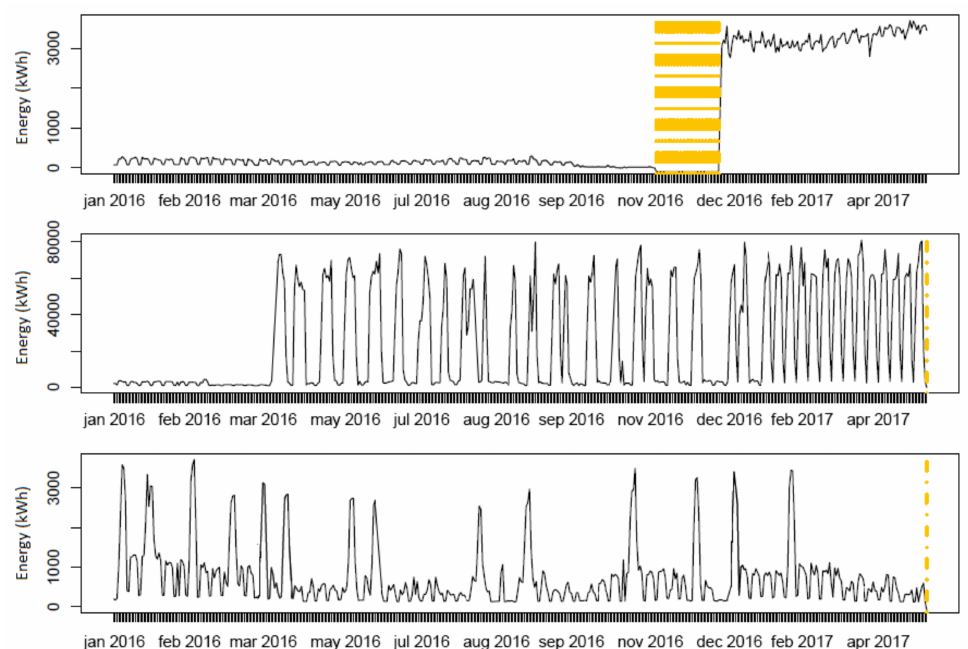
Figure 20. Three examples of anomalous detection (large changes on weekday/month